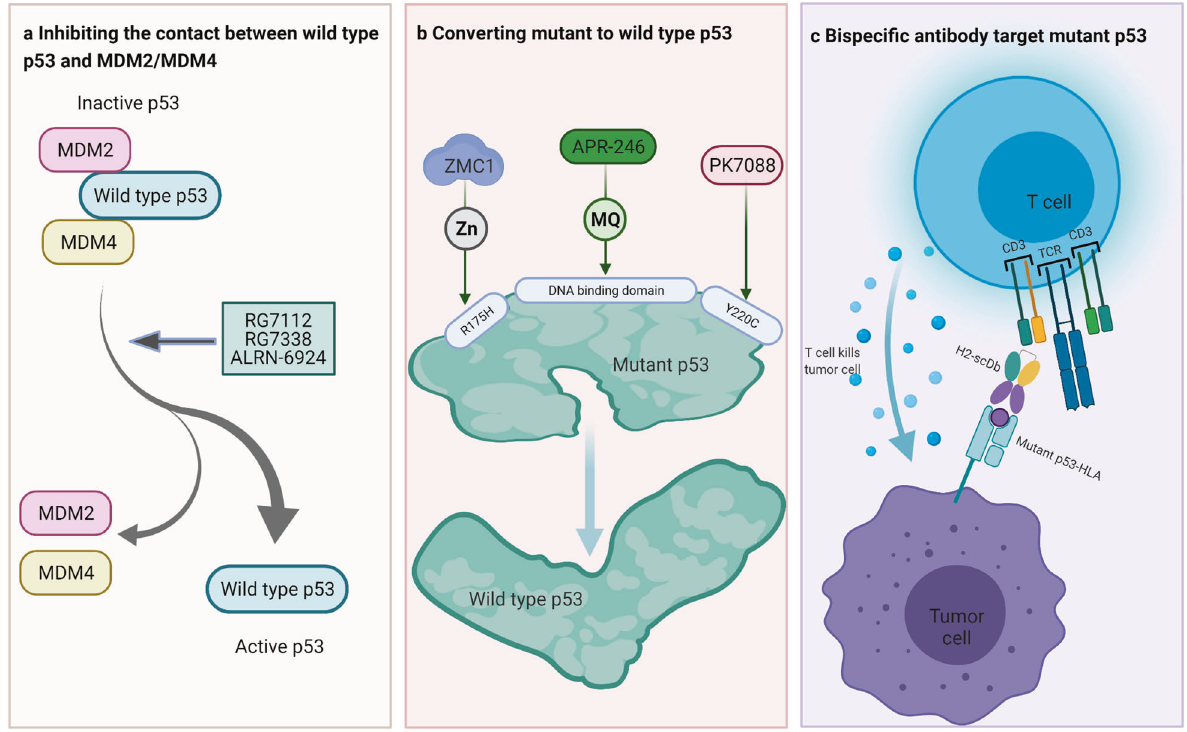
Fig. 1 Treatment strategies of p53 dysfunction. a Inhibition of the interaction between wild-type p53 and MDM2/MDM4: RG7112 and RG7338 are MDM2 inhibitors that hinder direct interaction between p53 and MDM2. ALRN-6924 is a dual MDM2/MDM4 inhibitor. RG7112, RG7338, and ALRN-6924 are currently undergoing clinical trials. b Restoration of wild-type p53 function: zinc metallochaperone-1 (ZMC1) restores the low Zn 2 + af fi nity of mutant p53 induced by R175H mutation and enables mutant p53 to fold correctly. APR-246 is converted to methylene quinuclidinone (MQ), a Michael acceptor that reacts with cysteines in the p53 core domain, promoting wild-type p53 conformation. PK7088 binds to Y220C mutant, regulating tail protein stability and enhancing correct protein folding of mutant p53. c Bispeci fi c antibody targeting mutant p53: H2-scDb binds to the p53 R175H peptide – HLA complex expressed on the tumor cell surface with one arm and to CD3 with the other arm, inducing T-cell activation and tumor single-chain BsAbs targeting mutant tumor neoantigens. First, single-chain BsAbs are small molecules that are rapidly cleared from the blood in humans and mice and therefore lack a sustained effect. 5 Second, human classical HLA class I is highly polymorphic, narrowing the range of patients that can be treated with mutation-associated neoantigen peptide – HLA-targeted therapy. 5 For example, HLA-A*02:01 is one of the most common HLA haplotypes in Caucasians and Native Americans but varies among